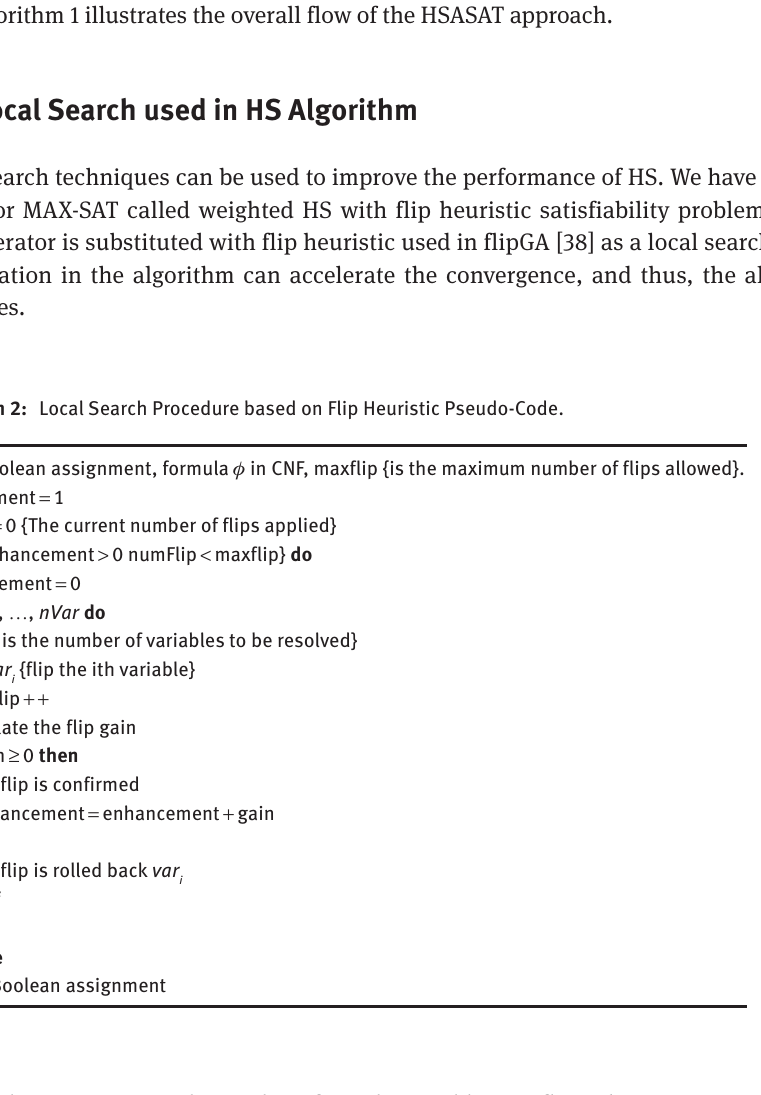
Figure 2: Binary Representation of Harmony.